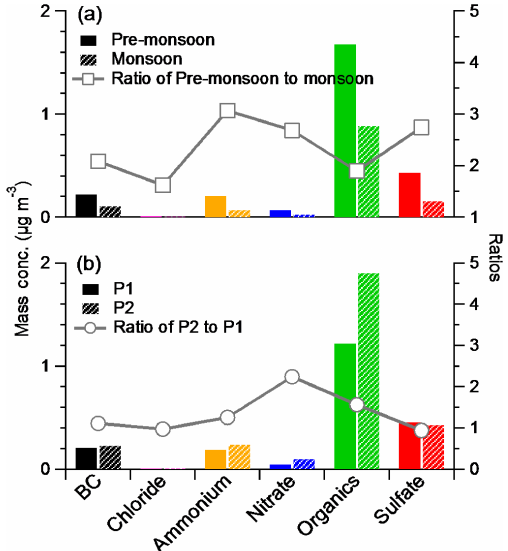
Figure 4. The comparisons of PM 1 species of the mass concen- tration (left axis) and the ratio between them (right axis) between (a) pre-monsoon and monsoon and (b) P1 and